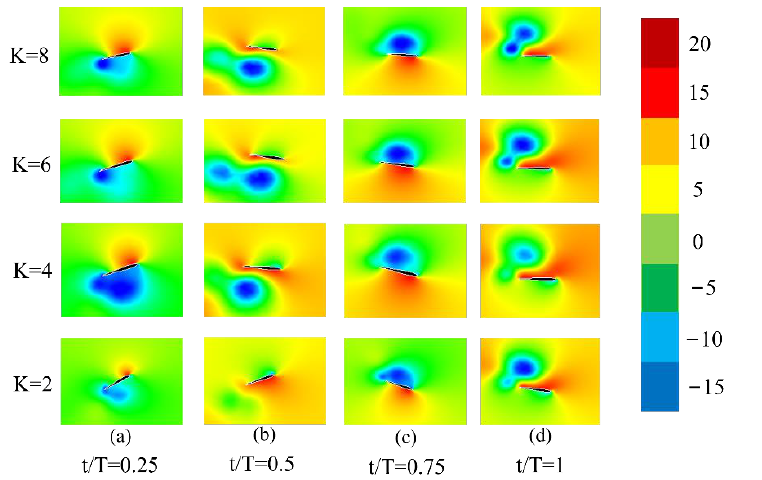
Figure 13. The pressure nephogram of the conventional submerged glider under the different K in a single cycle. ( a ) t/T = 0.25; ( b ) t/T = 0.5; ( c ) t/T = 0.75; and ( d ) t/T = 1.